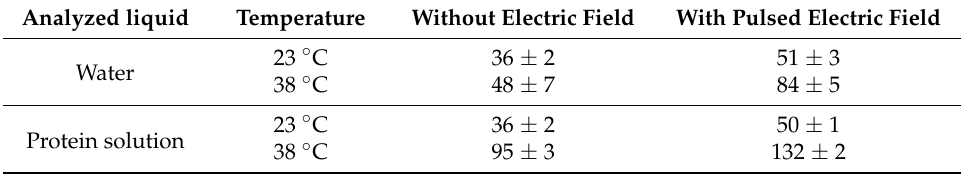
Figure 3. Typical ∆ q(t) dependencies obtained in the absence (white markers) and in the presence (dark markers) of an electric field for water ( a ) and protein solution ( b ) at 23 ◦ C. The data of one and the same experimental series obtained using one and the same tube-pipe-tip set (see “Materials and Methods” section) are presented. Table 2. Value of charge accumulated in the cell with the electric field present, in nC. Analyzed